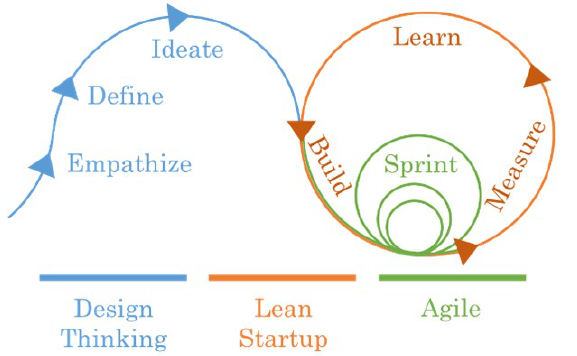
Figure 7. Generic Design Thinking–Lean Startup–Agile process.